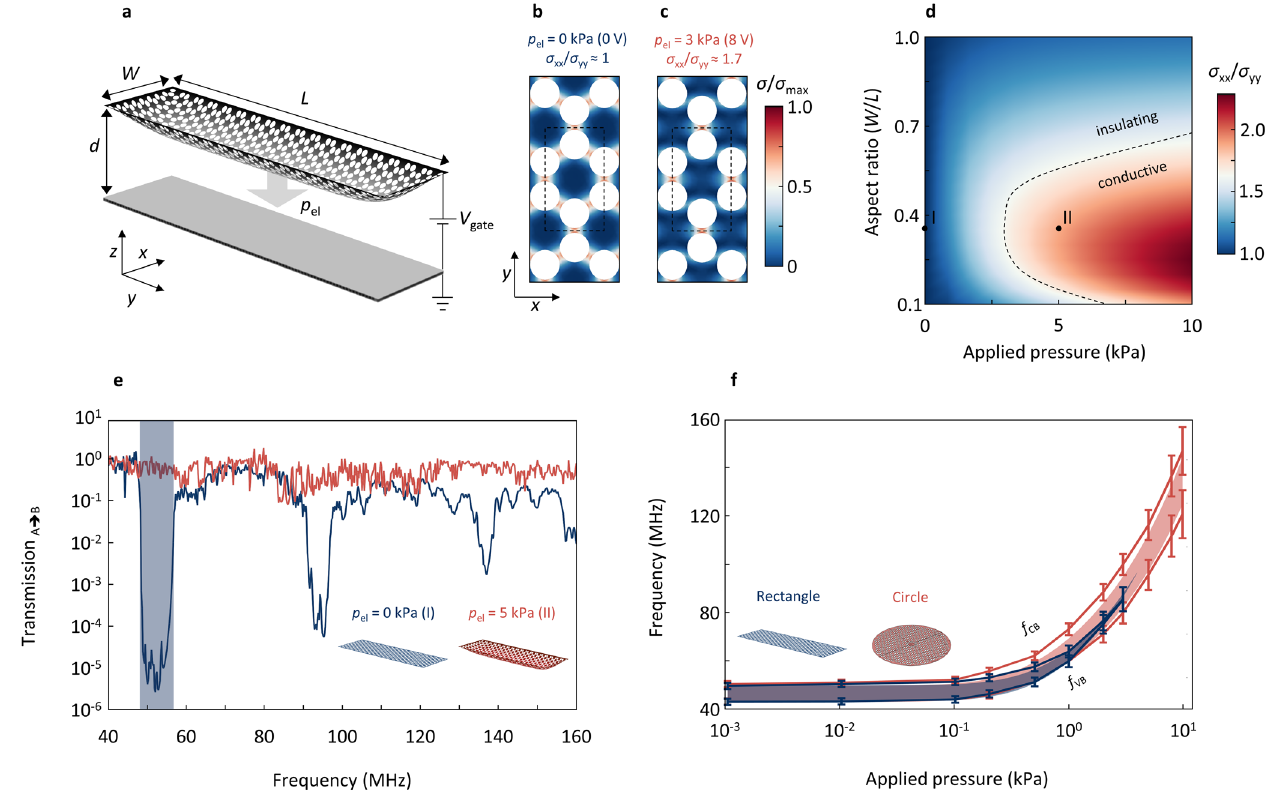
Fig. 3 Uniaxial tension engineering in a fi nite-size phononic system. a Sketch of a fi nite-size system phononic device, which is mechanically deformed under electrostatic pressure, p el , generated by a gate electrode below the graphene. b , c Spatial tension distribution in the centre of the device with and without applied pressure. The dashed lines indicate the unit cell of the lattice. d Mechanical phase diagram: Tension uniaxiality ( σ xx / σ yy ) vs. pressure vs. device aspect ratio (W/L). The dotted line corresponds to σ xx / σ yy = 1.7, the degree in uniaxiality needed to close the bandgap. e Transmission for a device with an aspect ratio of 0.32 for p el = 0 kPa (blue) and 5 kPa (red). The initially pronounced bandgap vanishes with applied pressure. f Extracted valence band maximum ( f VB ) and conduction band minimum ( f CB ) vs. applied pressure for a rectangular device (blue, shown in a ) and a circular device (red) as reference for uniform scaling ( σ xx / σ yy ≈ 1). For the rectangular device the bandgap closing occurs at 3 kPa, whereas the circular device maintains a bandgap over the entire range of applied pressures. The error bars depict the reading error of the simulation results, and the shaded areas correspond to the phononic bandgap extracted from band structure